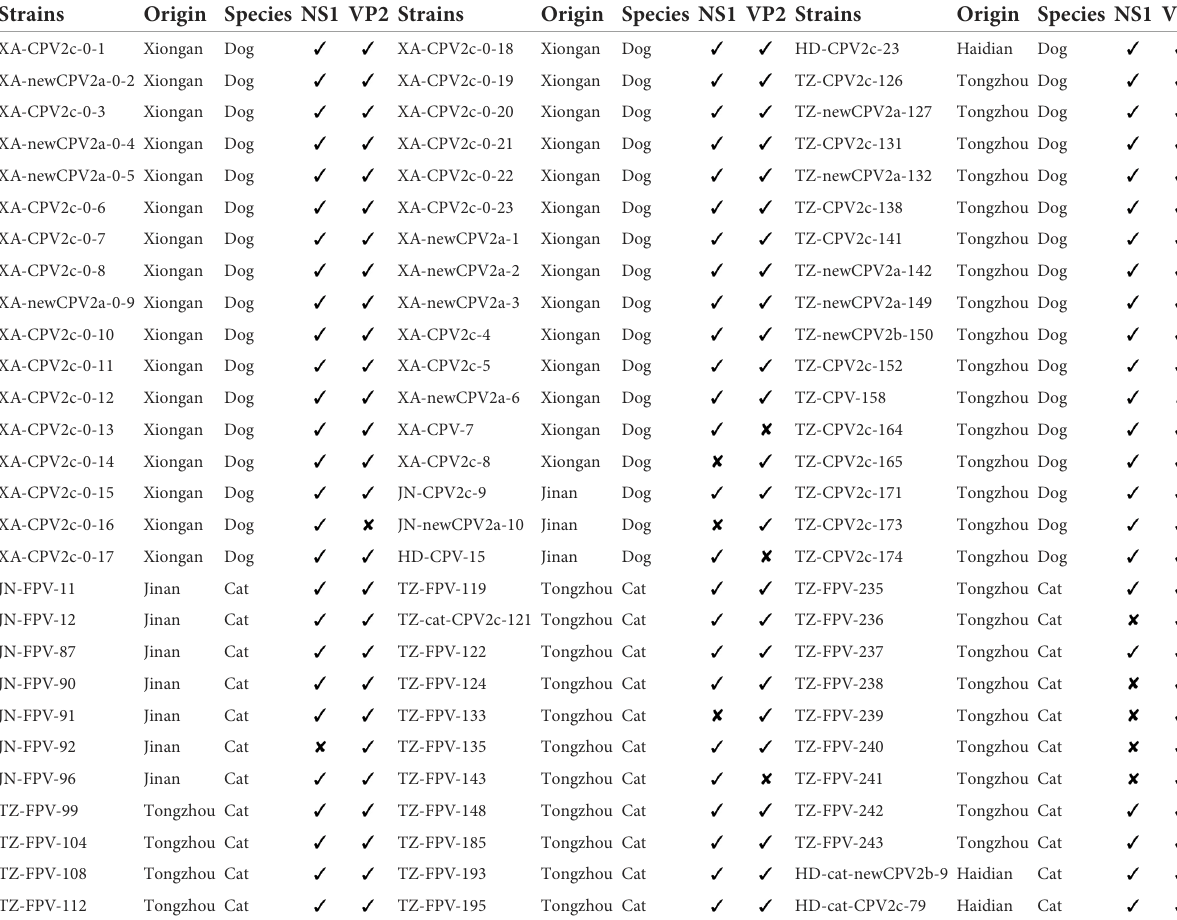
TABLE 1 Detailed description of canine parvovirus type 2 (CPV-2) and feline panleukopenia virus (FPV) characterized in this